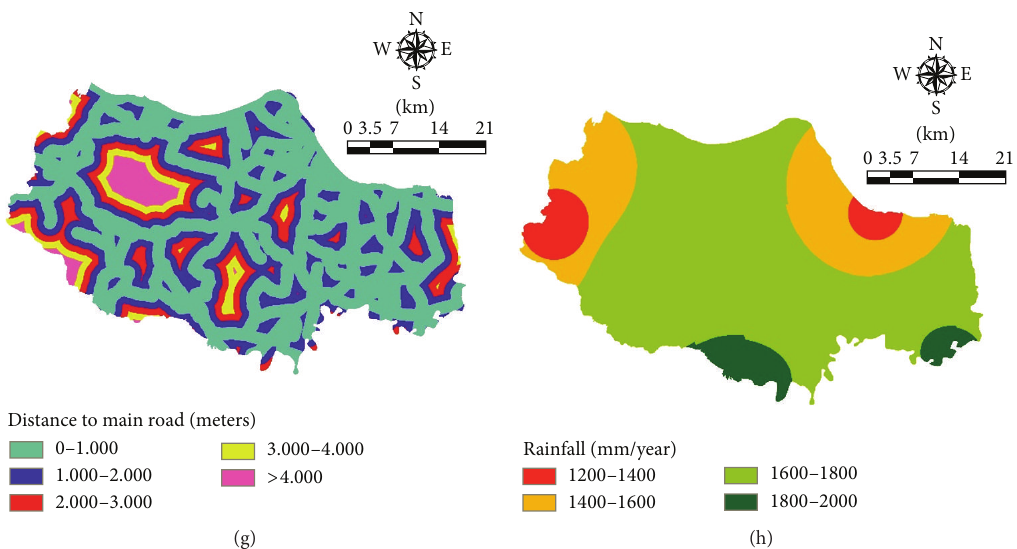
Figure 3: Criteria used for land suitability analysis in Tuban Regency: (a) soil order 1 , (b) land capability class 1 , (c) elevation 2 , (d) slope 1,2 , (e) slope direction 2 , (f) land use/land cover 1 , (g) distance to main road 2 , and (h) rainfall 2 (source of figures: 1 [11]; 2 analysis for this paper).